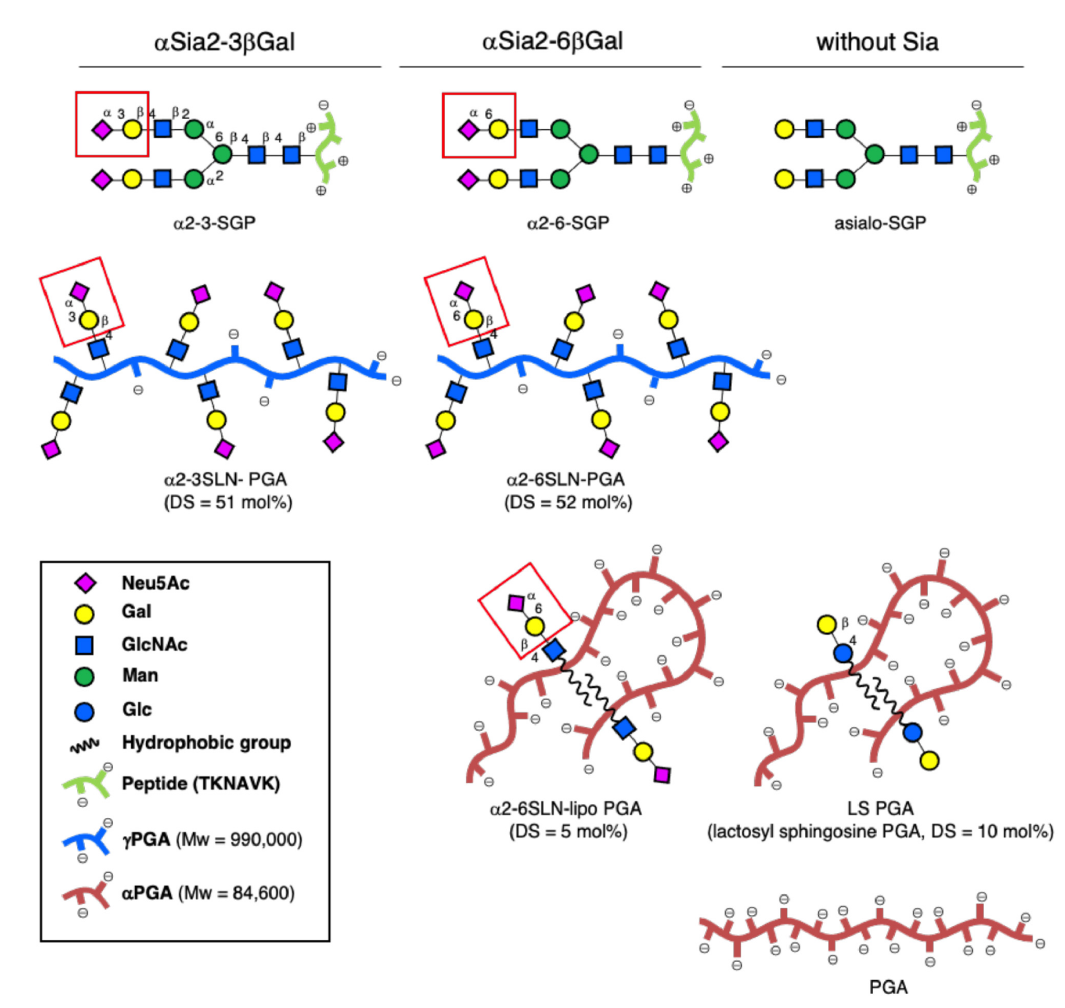
Fig 1. Schematic structures of sialylglyco-polyglutamic acid (PGA) and sialylglycopeptide (SGP). Structures of compounds investigated are shown in a line-column formation. First row: a series of SGP; Second Raw: γ -PGA bearing glycans; Third Row: α - PGA bearing glycans. First column: glycan carrying α -2-3-linked glycosides of sialic acid; Second column: glycan carrying α -2-6- linked glycosides of sialic acid; Third column: compounds without sialic acid. Cartoon presentations of glycans are shown as suggested by the Consortium for Functional Glycomics. Average molecular weights for α - and γ -PGA together with degree of substitution (DS) provide overall structures of polymeric compounds. Polymers carrying “lipo”-functions form self-aggregates.